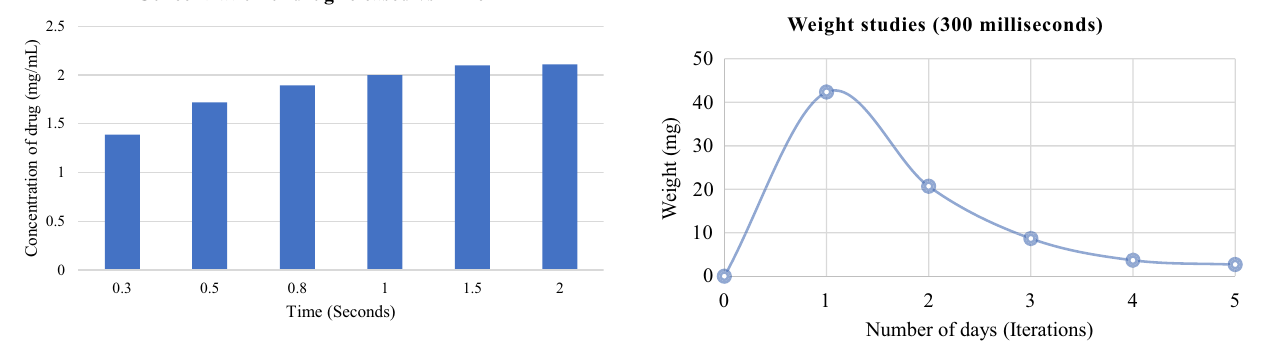
Fig. 8 In vitro drug release kinetics